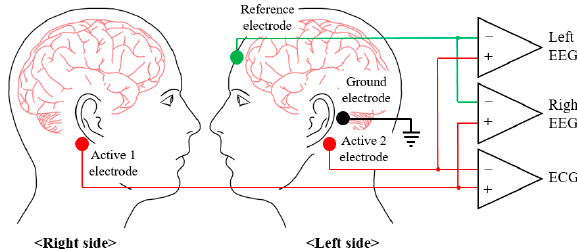
Figure 2. Placements and differential inputs of the electrodes for recording of the two EEG signals and one ECG signal (Active 1 – Active 2 = ECG, Active 1 − Reference = Right EEG, Active 2 − Reference = Left EEG).